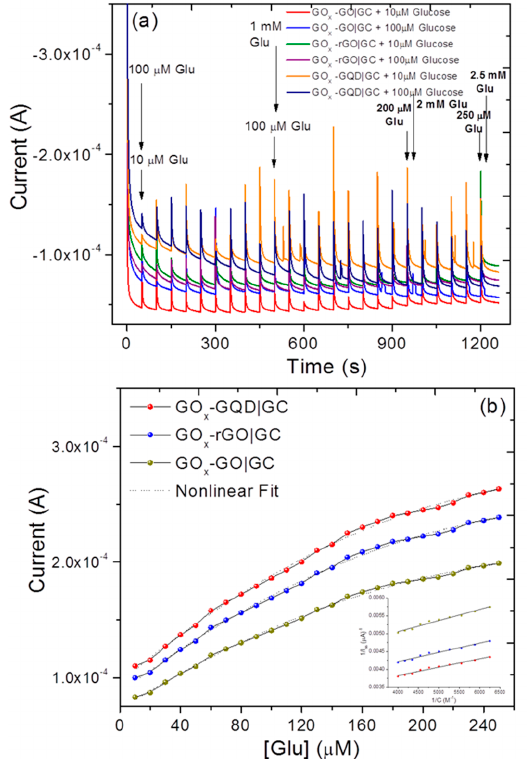
Figure 6. ( a ) Representative amperometric response ( i - t ) to successive addition of 10 μ M and 100 μ M glucose step under conditions: − 0.4 V constant potential, 0.1 M PBS, pH 7.4 in interval of 50 s until 1200 s on various electroanalytical platforms [GO x -(GO, rGO, GQD)|GC] and ( b ) chronoamperometric current versus glucose concentration (100 mM) amperograms obtained from ( a ). Inset in ( b ) shows Lineweaver–Burk plot for K m value determination.